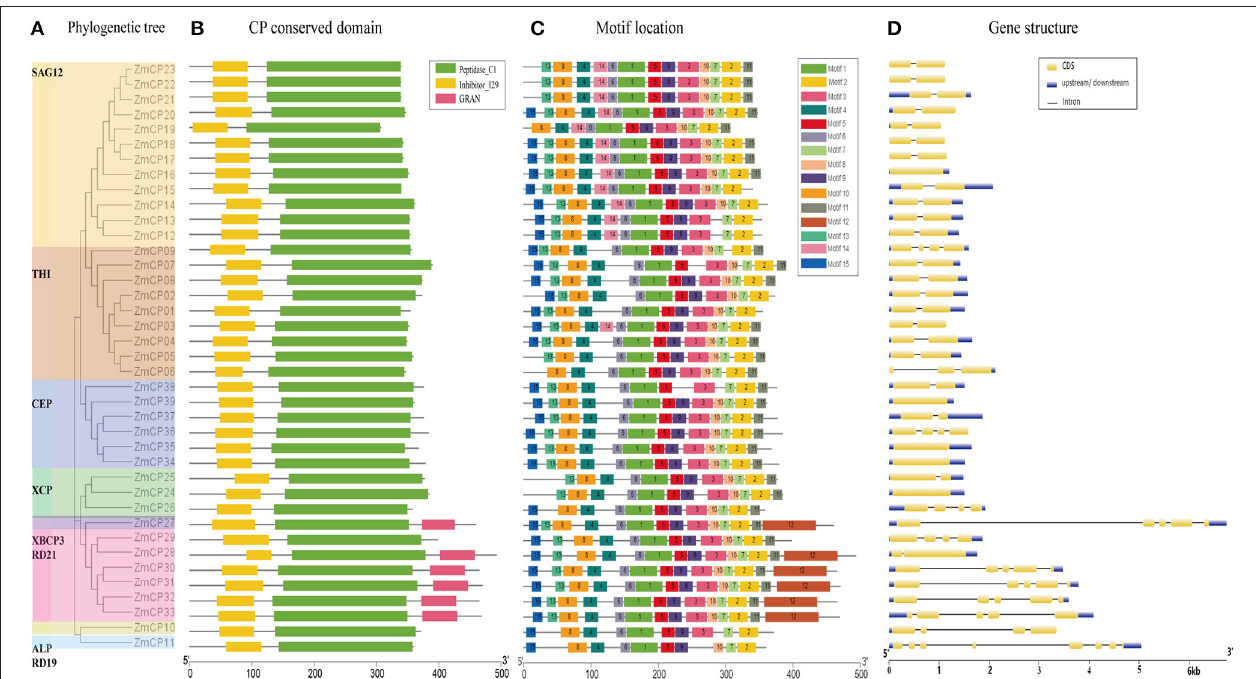
FIGURE 2 | Evolutionary analysis, motif compositions, and gene structures of 39 ZmCPs . (A) The unrooted phylogenetic tree. (B) The conversed domain in ZmCPs . (C) The motif location in ZmCPs. (D) The gene structures of 39 ZmCPs .